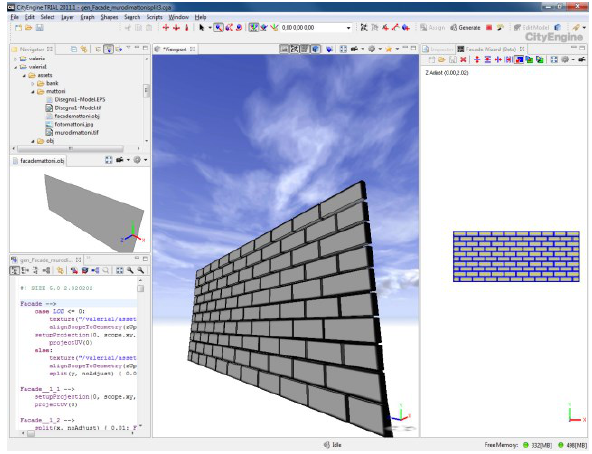
Figure 1. Cityengine test reproducing opus vittatum